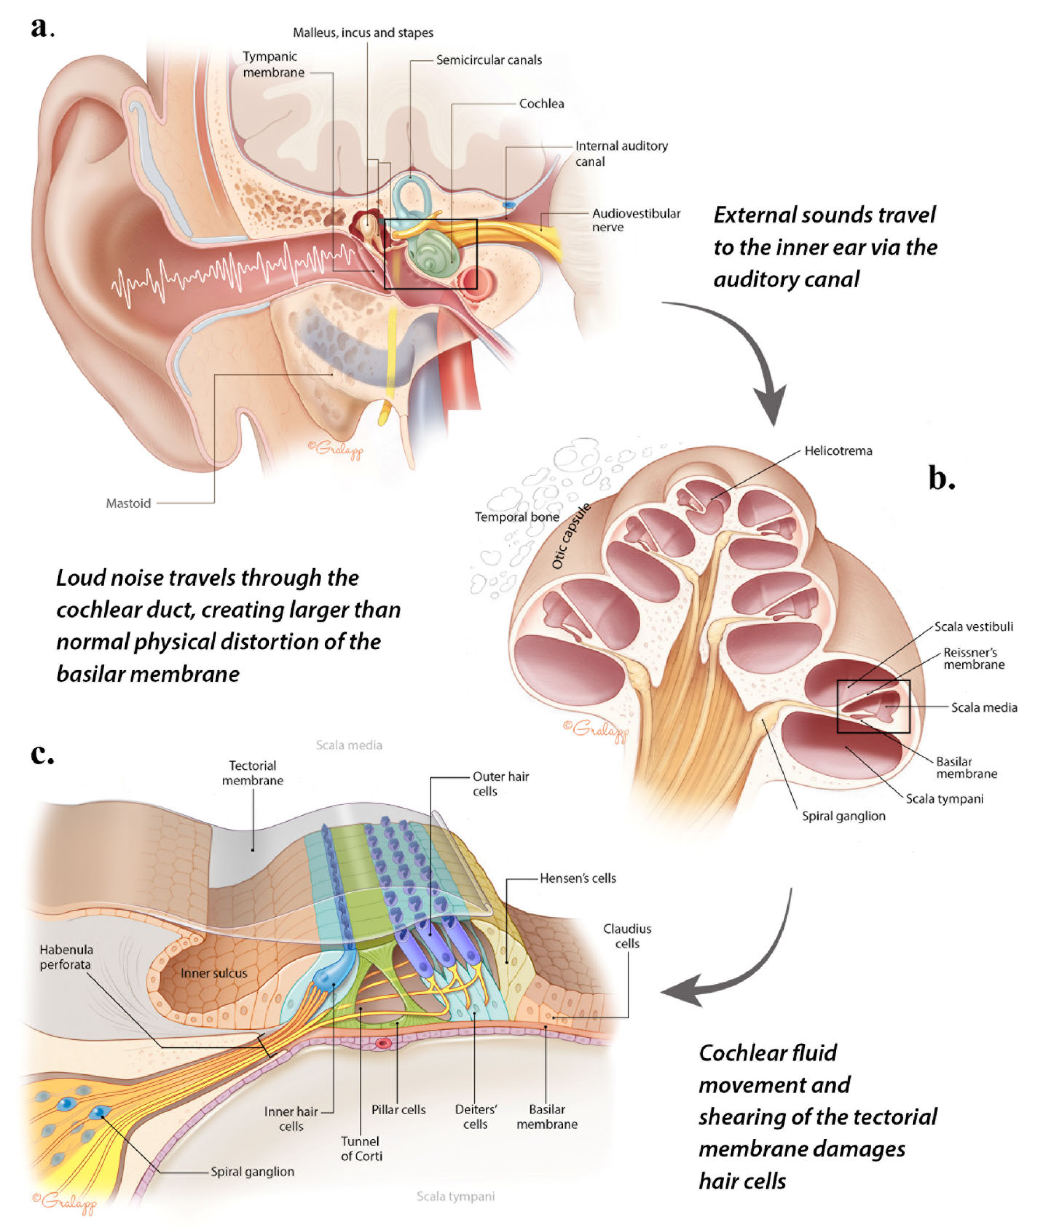
Figure 2. Anatomical structures of the inner ear impacted by NIHL. Three-panel diagram illustrating ( a ) cross section of gross outer, middle, and inner ear anatomy; ( b ) cross-sectional anatomy of the cochlea; ( c ) cellular-level anatomy of the sensory epithelium of the cochlea (organ of Corti). Original illustrations by Christine Gralapp and used with permission.